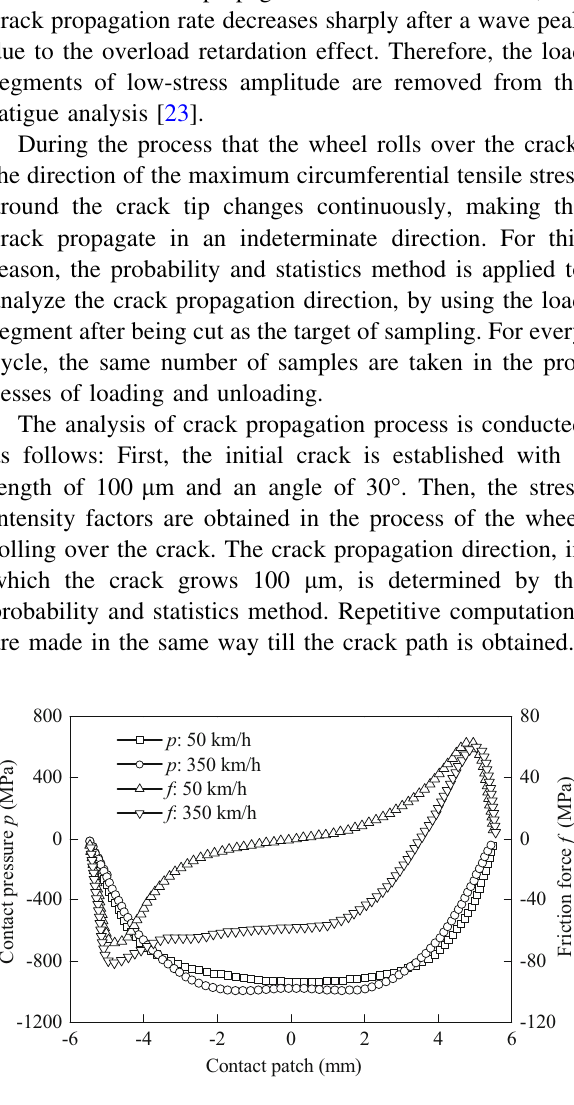
Fig. 6 Variation of stress intensity factor at crack tip with the crack length for different train speeds: a 50 km/h; b 350